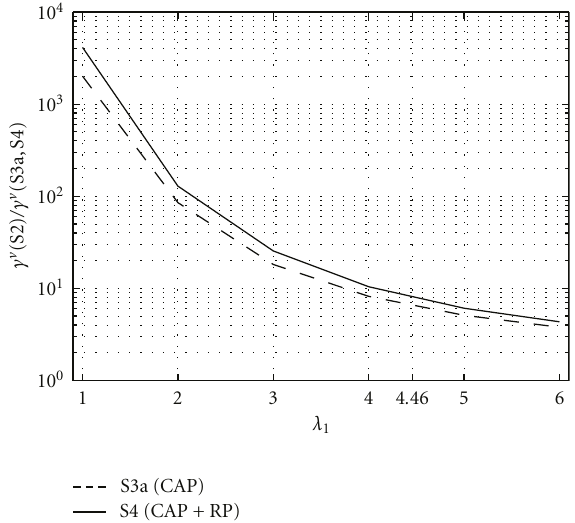
Figure 4: Interference reduction factor with the arrival rate of primary users when λ 2 =